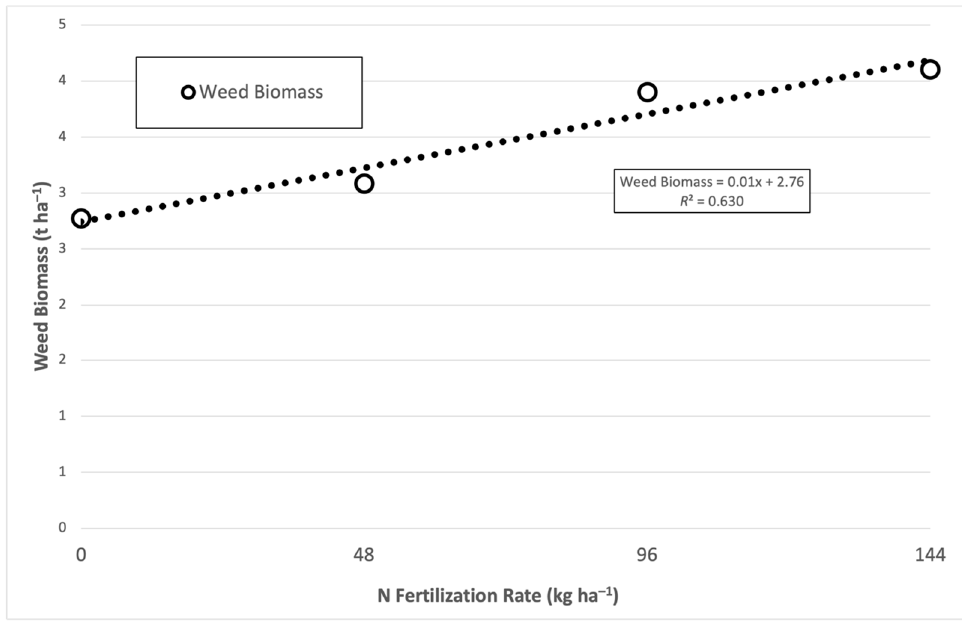
Figure 9. Mean weed biomass as a function of N fertilization rate in 2021. Goodness of fit described with conditional R 2 . Table 4. Mean sweet corn N uptake and agronomic N use efficiency following different cover crop terminations and N fertilizer rates in South Deerfield,